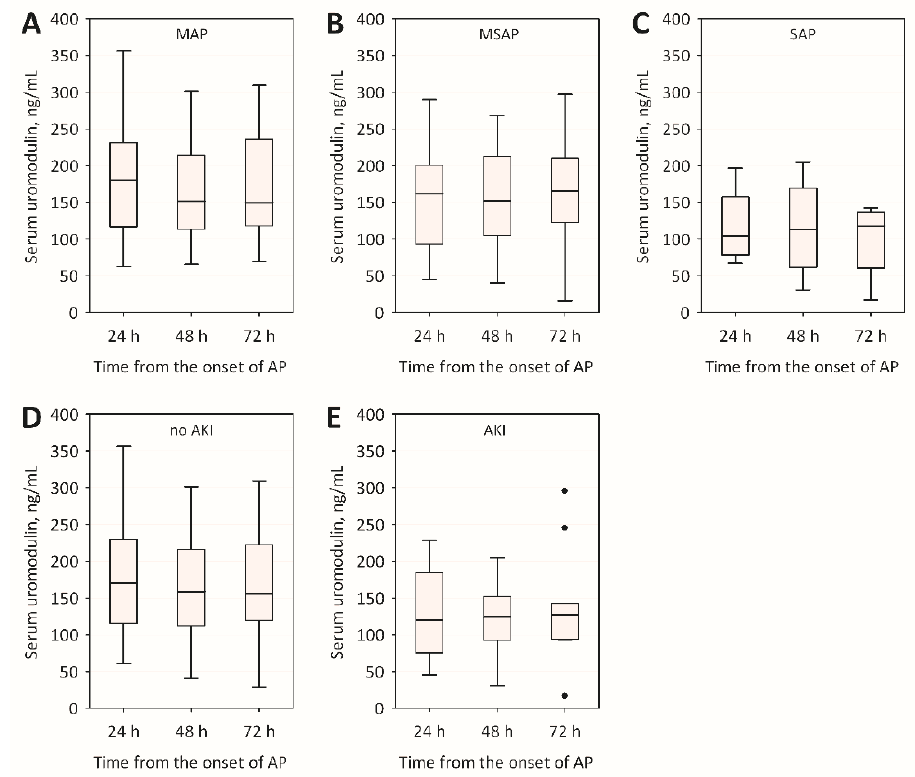
Figure 1. Changes in serum uromodulin concentrations during the first 72 h of acute pancreatitis among patients with: mild acute pancreatitis (MAP) ( A ); moderately-severe acute pancreatitis (MSAP) ( B ); and severe acute pancreatitis (SAP) ( C ); as well as among patients: without acute kidney injury (AKI) ( D ); and with AKI ( E ).